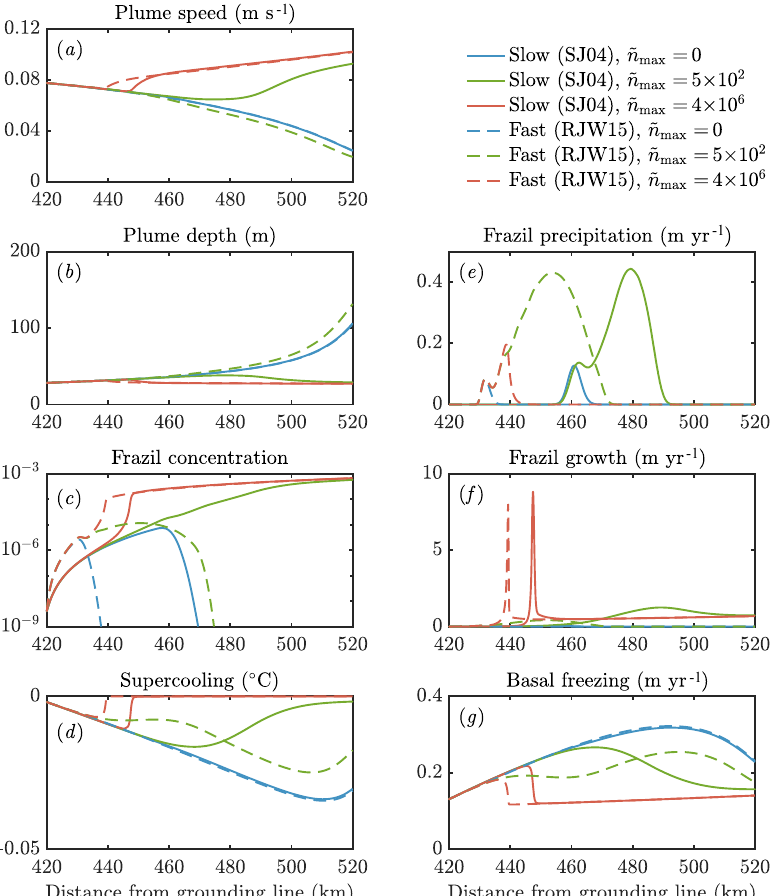
Figure 9. The sensitivity of the dynamics of a frazil-laden plume to parameterizations of crystal growth and nucleation. We perform calcula- tions with no secondary nucleation (blue), intermediate nucleation (green), and high nucleation (red). Solid lines denote slow crystal growth SJ04 (Smedsrud and Jenkins, 2004), one of the class of growth laws we labelled f 3 previously. Dashed lines denote fast crystal growth RJW15 (Rees Jones and Wells, 2015), previously labelled f 1 . Calculations with the growth law f 2 based on SO94 (Svensson and Omstedt, 1994) are very similar to the RJW15 results. Note that in the model of SJ04 a constant aspect ratio of 0.02 is assumed, whereas in SO94 and RJW15 a constant thickness 0.05mm is assumed. Note also that the solid red curve in panel (e) is approximately